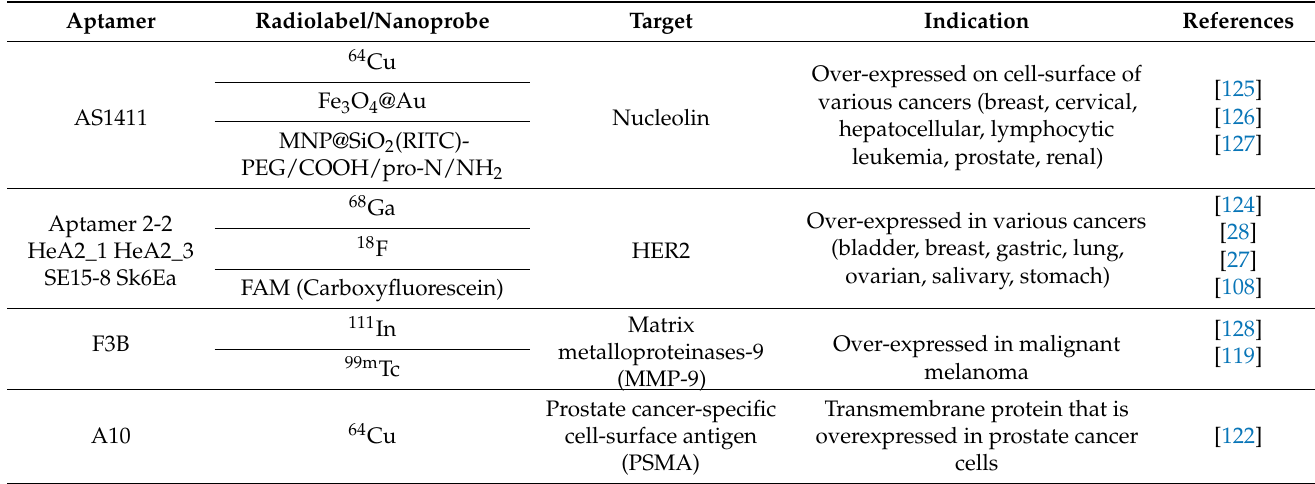
Table 2. Different aptamers radiolabelled for molecular imaging